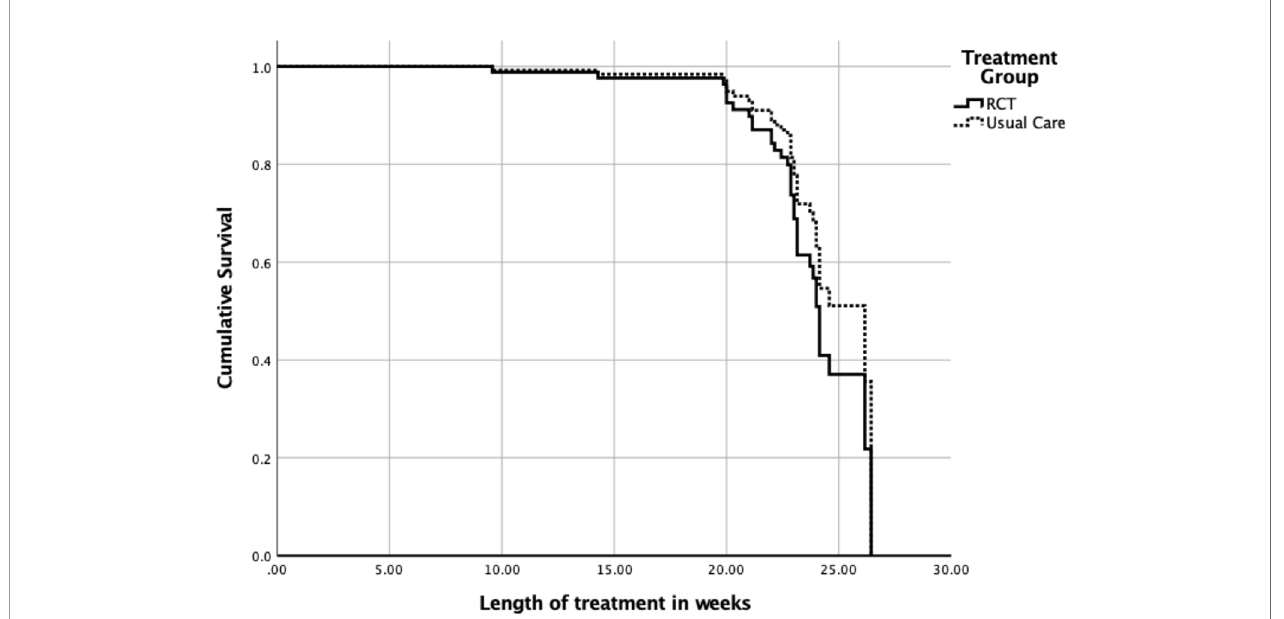
FIGURE 1 | Time to weight restoration for randomized clinical trial (RCT) care vs. non-research specialty